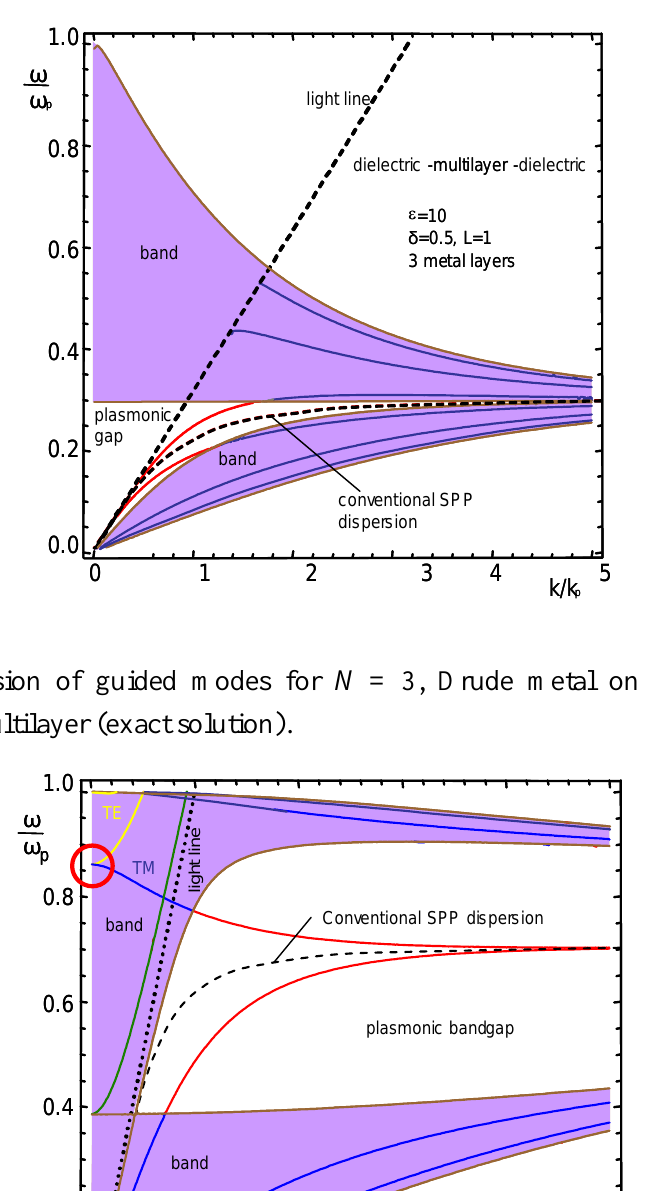
Figure 4. Dispersion of guided modes for N = 3, dielectric  = 10 on both sides of the nanomembrane multilayer (exact solution).